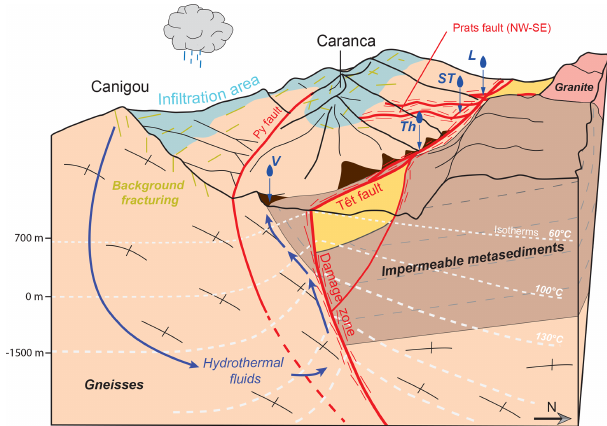
Figure 3. Conceptual model of hydrothermal circulations in the footwall of the dormant Têt fault (hot spring cluster: L: Llo, ST: St Thomas, Th: Thuès-les-bains, V: Vernet-les-bains). Variscan my- lonites are in dark brown, and Neogene basins are in yellow (modi- fied after Taillefer et al., 2017).